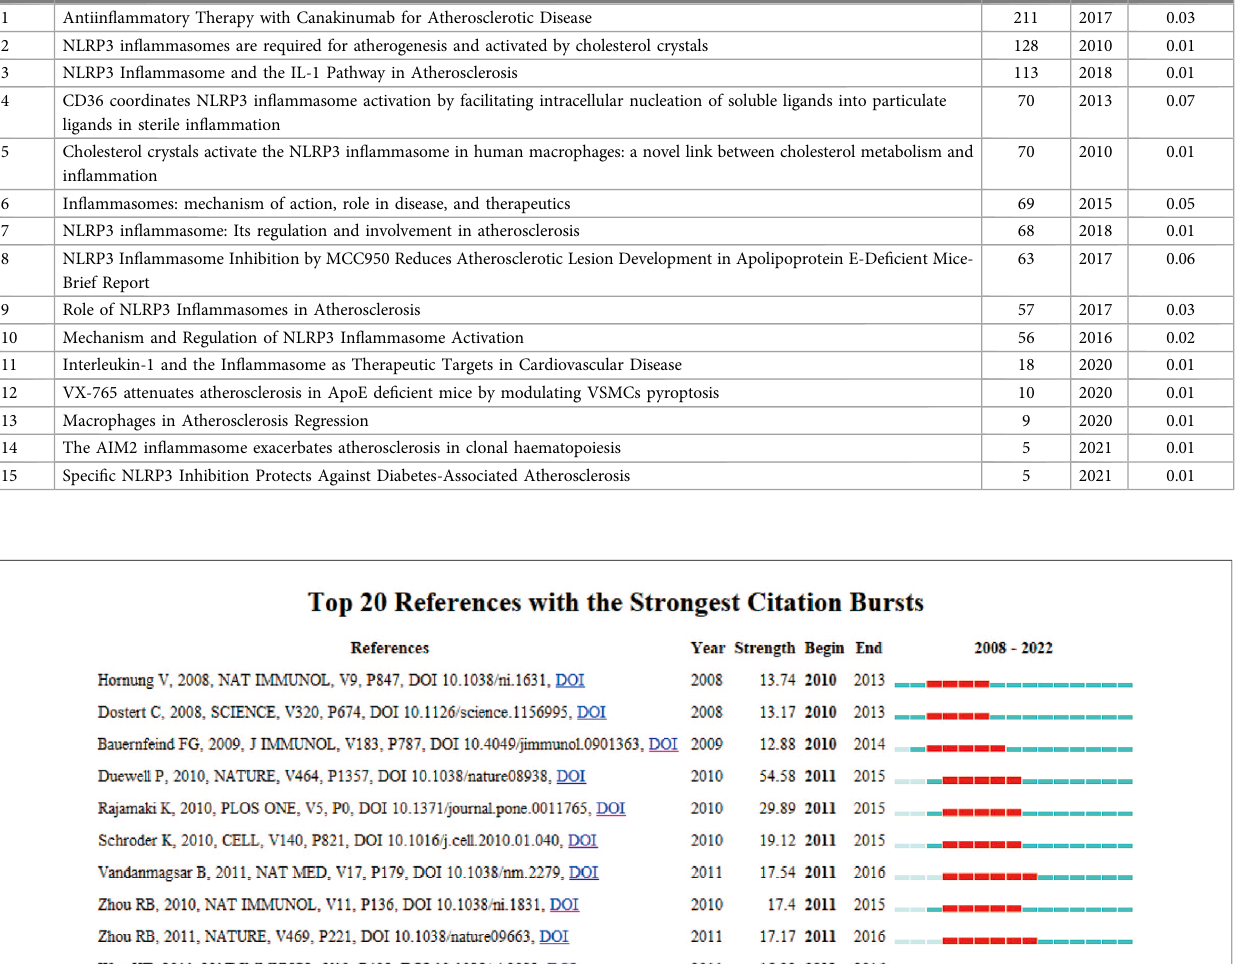
TABLE 6 Top 15 cocitation of cited reference on “ in fl ammasome AND atherosclerosis ” . Rank Reference Citation Year